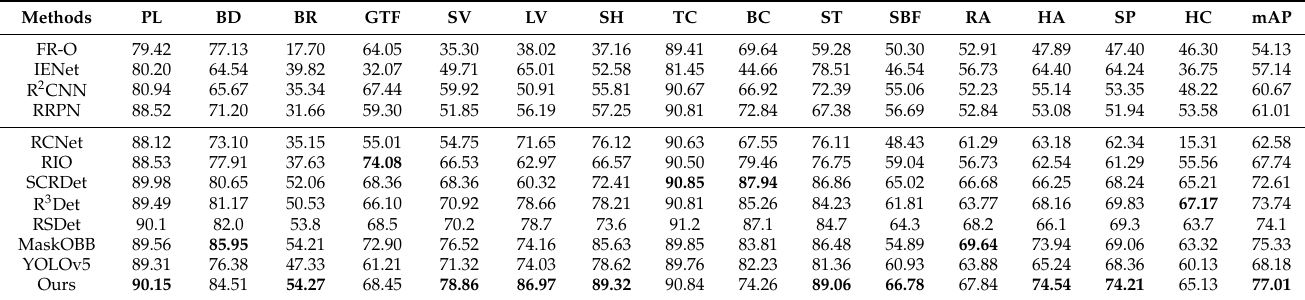
Table 1. Comparison of experimental results of different methods for each category. Expression for each category in the table: PL for aircraft, BD for baseball field, BR for bridge, GTF for track and field, SV for small car, LV for large car, SH for boat, TC for tennis court, BC for basketball court, ST for oil storage tank, SBF for football field, RA for circular lane, HA for port, SP for swimming pool, HC for helicopter.